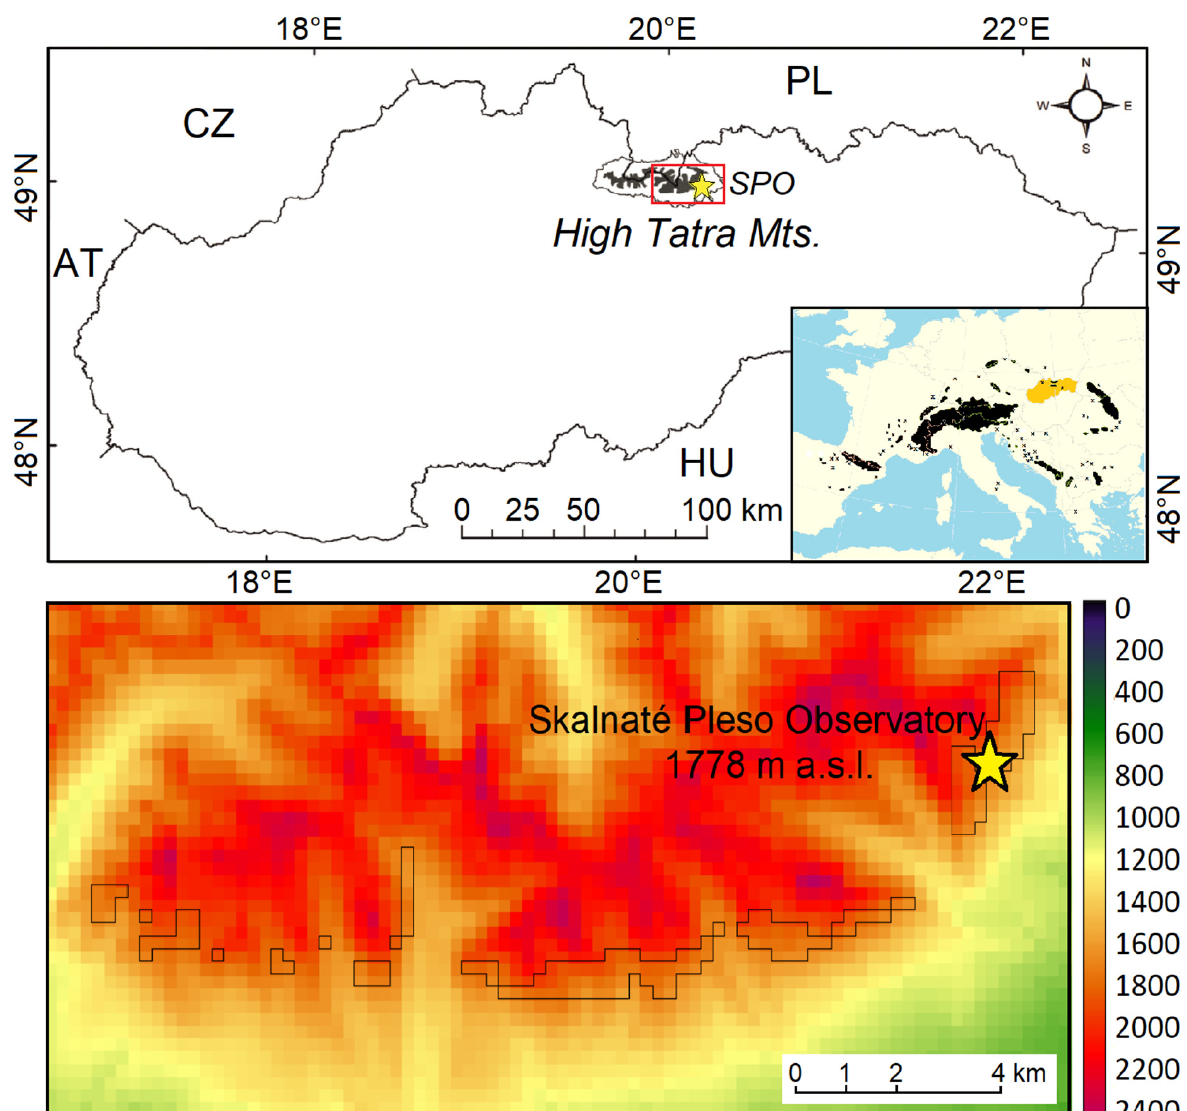
Figure 1. The location of High Tatra Mts in Slovakia (upper). The inset shows the Pinus mugo communities in Europe and the location of Slovakia (yellow). The lower image shows the studied area with the location of the analysed pixels bounded in black lines. The yellow star marks the location of the Skalnaté Pleso Observatory (SPO) in both images.